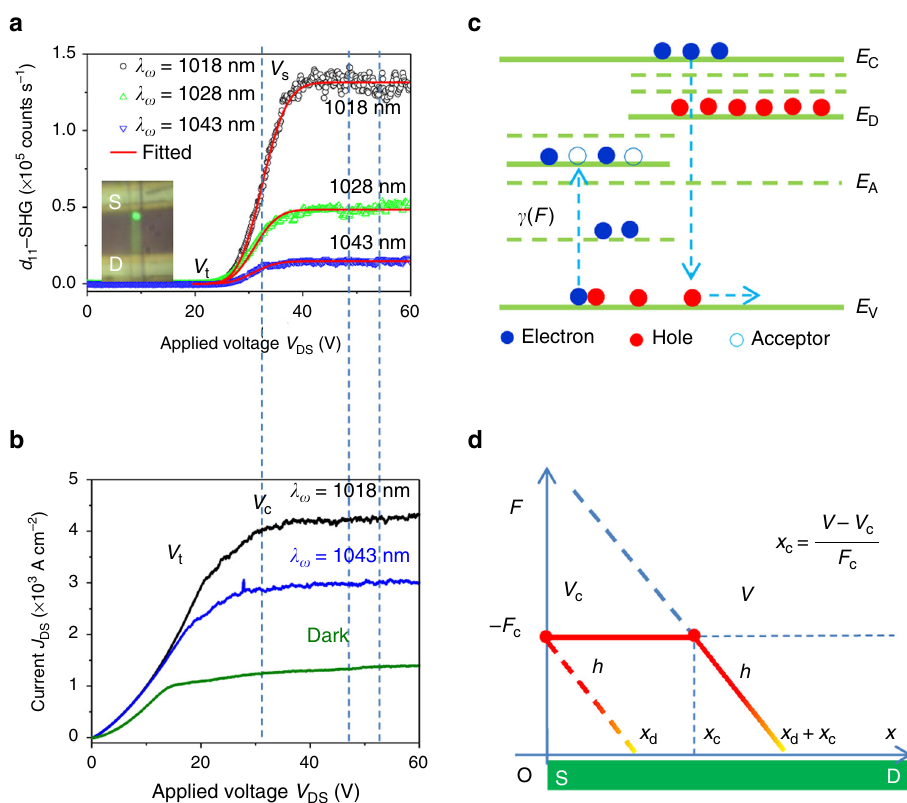
Fig. 2 Voltage-controlled d 11 -SHG signal and mechanism in CdS nanobelt. a d 11 -SHG signal as a function of applied voltage under three excitation wavelengths, 1018, 1028, and 1043 nm. Each curve includes three different regions, V DS < V t , V t < V DS < V s and V DS > V s . Here V t is the turn-on voltage or threshold voltage while V s represents the saturation voltage where SHG signal begins to saturate. The d 11 -SHG response when V t < V DS < V s is fi tted by using equation 1 and Supplementary Equation 19 in Supplementary Note 4. b I – V characteristics of the device in the dark and under excitation at 1018 and 1043 nm. V c stands for the saturation current – voltage. c Schematic of the band structure with donors ( N D ) and deep deep-level acceptors ( N A ). Electrons (represented by blue dots) can be excited from the valence band to the accepter traps via a strong fi eld (i.e., fi eld-induced ionization of acceptor traps), to generate holes (represented by red dots), which can then recombine with electrons in the conduction band and also take part in conduction. γ is the transition rate driven by the electric fi eld. d Schematic of the electric fi eld pro fi le using the Schottky high- fi eld domain model. F c represents the critical fi eld at which fi eld-induced ionization takes place ef fi ciently when the applied bias V DS equals the critical bias voltage, V c , h ¼ qN D = ð ε r ε 0 Þ and x d ¼ F c = h . Please note that this is a simpli fi ed model by assuming the net space charge density ( ρ ) is changed from qN D to be zero at the critical electric fi